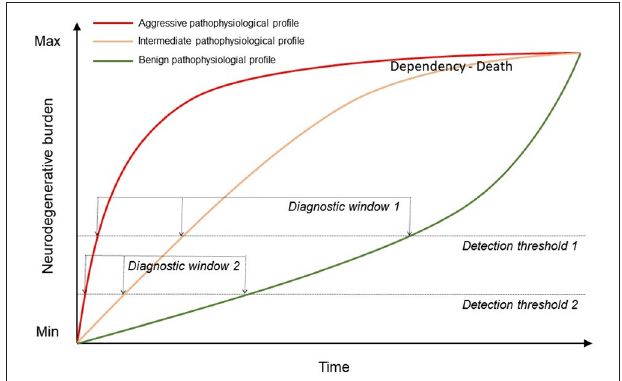
FIGURE 3 | Representation of the increasing neurodegenerative burden in patients with ALS over time depending on their pathophysiological profile. The use of biomarkers may help to improve the current detection threshold (detection threshold and diagnostic window 1) from 1 to earlier clinical stages and differentiating between profiles (detection threshold and diagnostic window